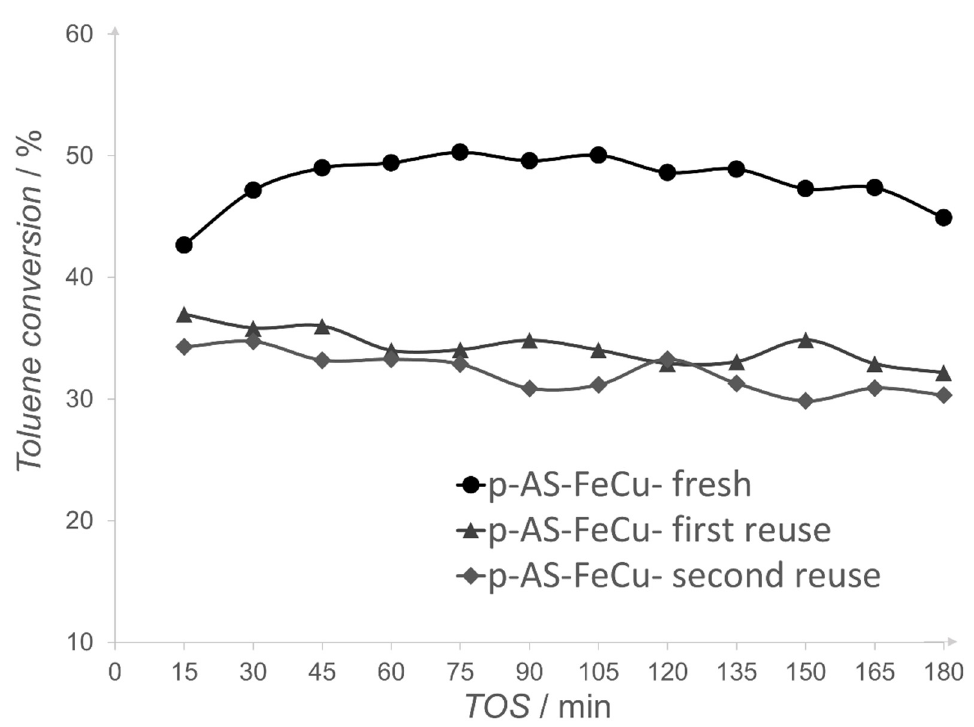
Figure 15. Time on stream (TOS) for catalyst “p-AS-FeCu”, with two reuse cycles. WHSV = 1.2h − 1 , T = 380 °C.